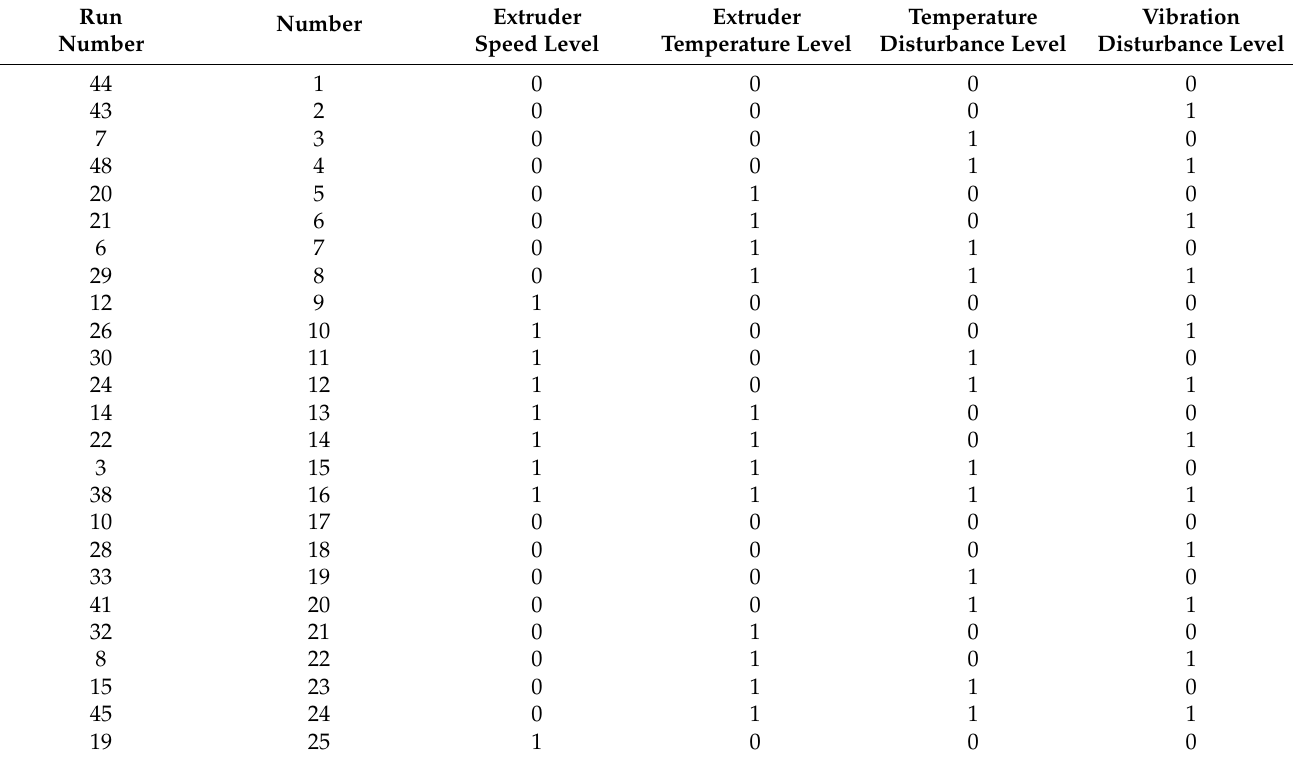
Table A1. Design of Experiment Table for Case Study